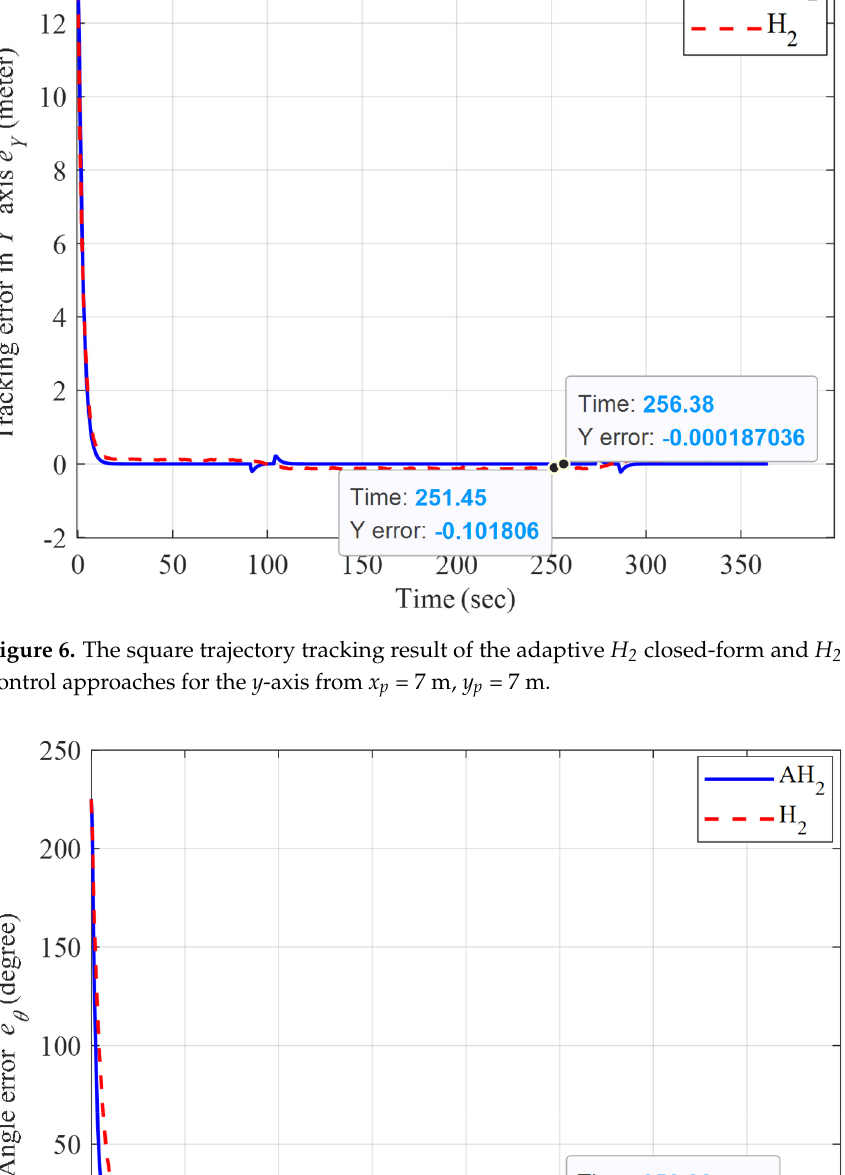
Figure 5. The square trajectory tracking result of the adaptive H 2 closed-form and H 2 closed-form control approaches for the x -axis from x p = 7 m, y p = 7 m.